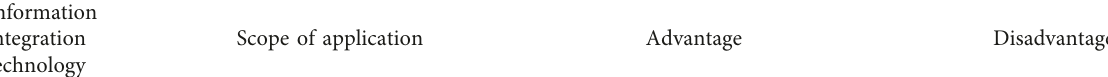
Table 1: Comparison of different information integration